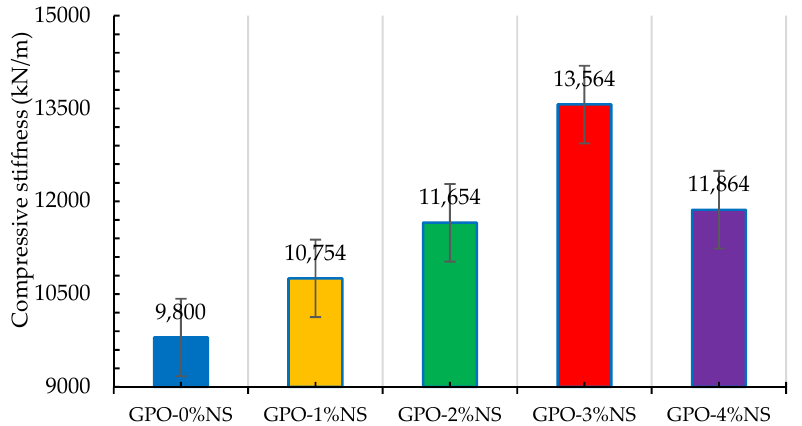
Figure 6. Effect of different quantities of NS on the compressive stiffness of GPO pastes.